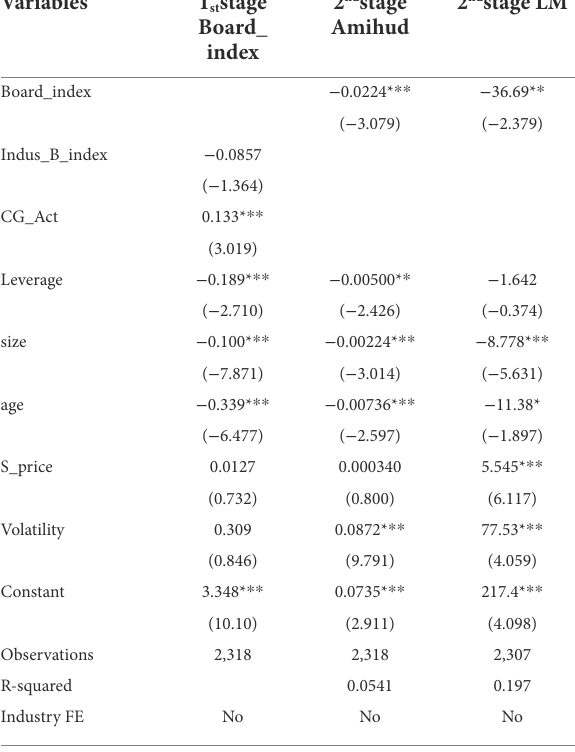
TABLE 5 Board index and stock liquidity (2SLS)